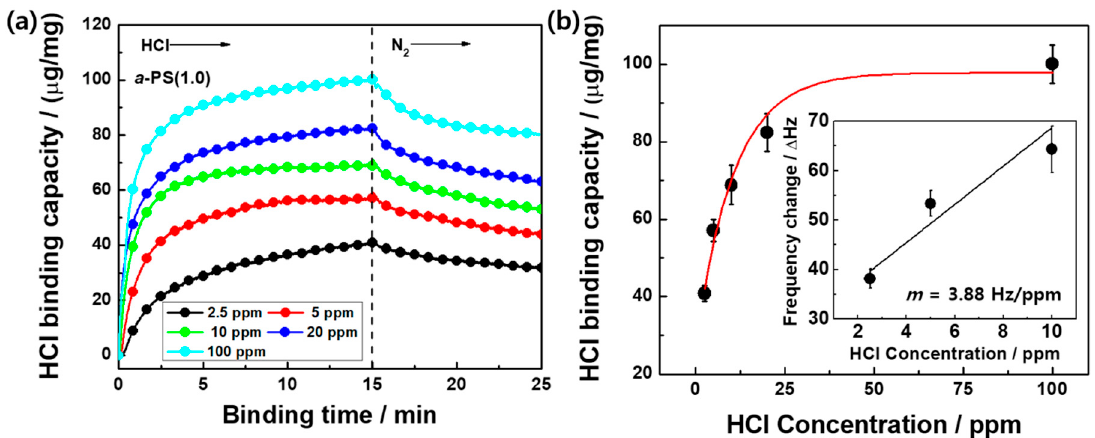
Figure 3. ( a ) The HCl binding capacity of the a -PS(1.0) sensor as a function of binding time (the process contains 15 min HCl injection and 10 min N 2 gas flow) and ( b ) HCl binding capacity of the a -PS(1.0) sensor as a function of HCl concentration (from 2.5 to 100 ppm) (inset: resonant frequency change for 15 min HCl gas flow in a range of 2.5–10 ppm).